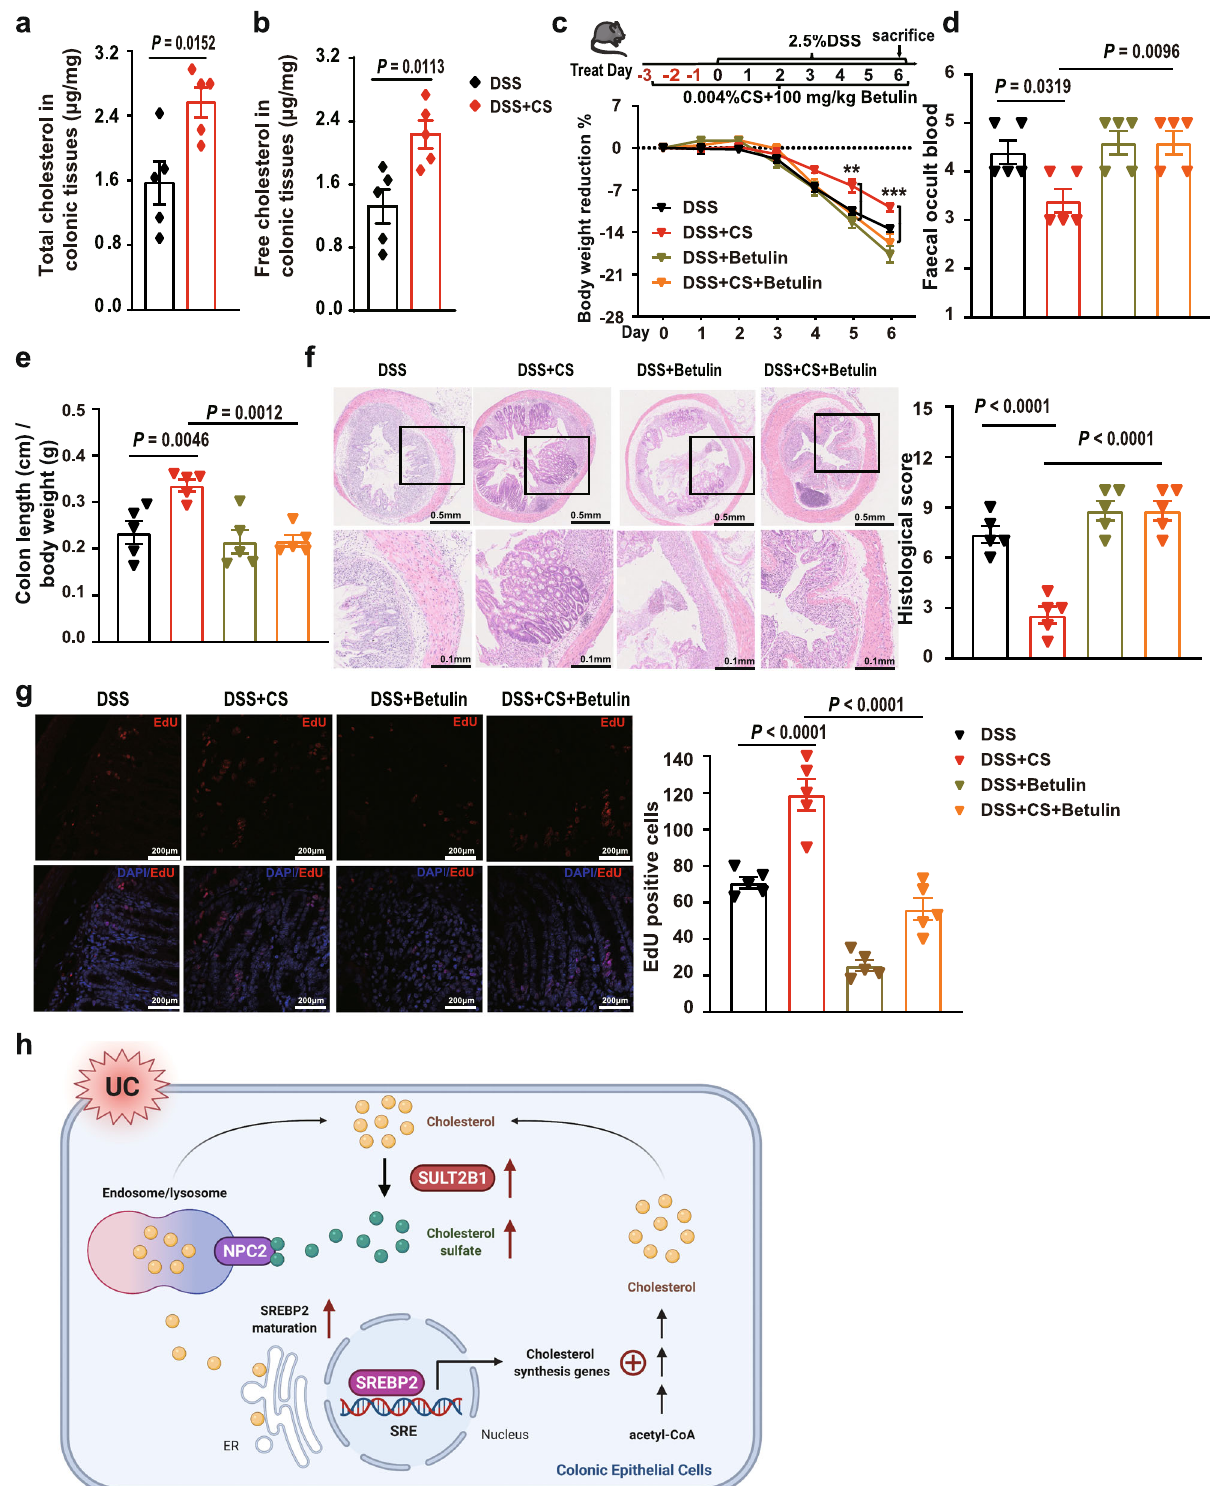
Fig.7|SREBP2inhibitorbetulinsuppressesthealleviationeffectsofCSonDSS- induced colitis in mice. a , b Total and free cholesterol content of colonic tis- sues from C57BL/6J mice in the presence or absence of CS (0.004%). ( n = 5 mice/group, two-tailed Student ’ s t -test). c Schematic diagram of treatment and body weight reduction rate in C57BL/6J, 0.004% CS-fed C57BL/6J, C57BL/ 6J+ betulin (100mg/kg), and 0.004% CS-fed C57BL/6J+ betulin (100mg/kg) mice during DSS challenge ( n =5 mice/group). Two-way ANOVA with Tukey ’ s multiplecomparisonstest,day5(DSS +CSvs.DSS+ CS+ Betulin)** P = 0.0065;